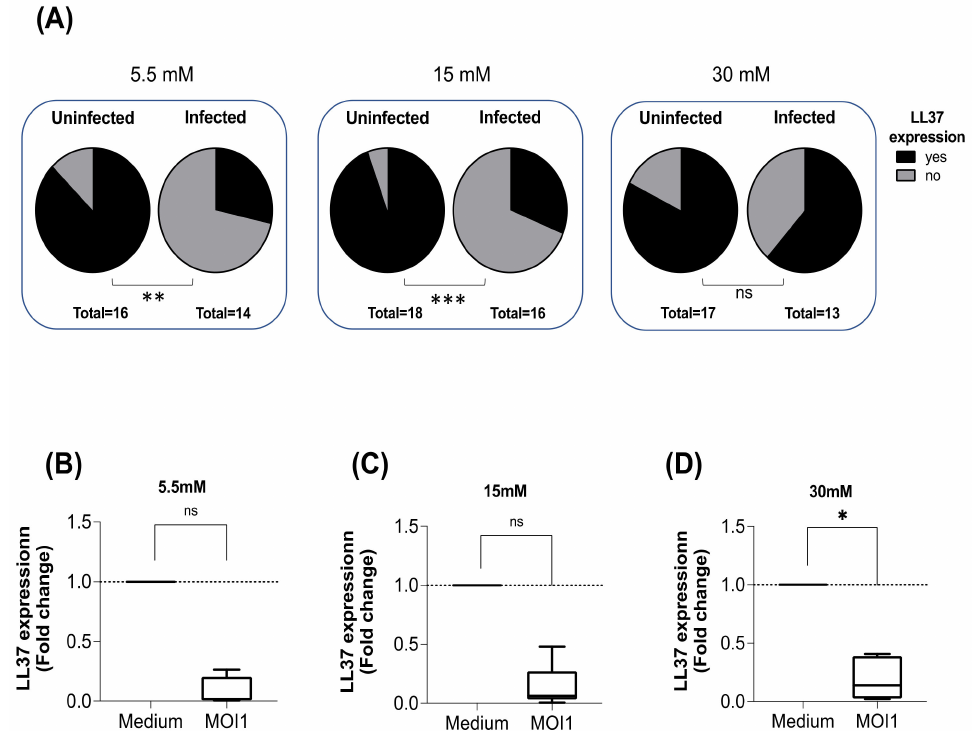
Figure 1. Effect of glucose and M. tuberculosis infection on LL37 expression. Macrophages were cultured for 24 h in different glucose concentrations (5.5, 15, or 30 mM) at 37 ◦ C and 5% CO 2 and then infected with M. tuberculosis H37Ra at MOI 1. After 24 h of incubation, the supernatants were removed, and the cells lysed for total RNA extraction, cDNA synthesis, and LL37 gene expression measurement by qPCR. Proportion of individuals expressing and unable to express LL37 ( A ), n = 16–18; ns: not significant, ** p < 0.01, *** p < 0.001, Fisher’s exact test for categorical variables. LL37 gene expression at 5.5 mM glucose ( B ), 15 mM glucose ( C ) , and 30 mM glucose; ( D ) depicted are box plots with median and quartiles. ns: not significant, * p < 0.01, Medium vs. M. tuberculosis (MOI 1), Wilcoxon